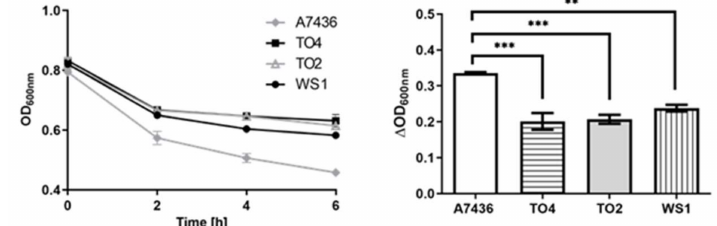
Figure 9. Interaction of S. gordonii with P. gingivalis strains. The tendency of S. gordonii to co-aggregate with P. gingivalis wild type (A7436) and mutant strains lacking hmuY (TO4), hmuR (WS1) and both hmuY and hmuR genes was monitored by measuring optical density at 600 nm at the indicated time points (left panel) or after 6 h (right panel). A7436, wild type P. gingivalis strain; TO4, ∆ hmuY mutant strain; TO2, ∆ hmuY ∆ hmuR mutant strain; WS1, ∆ hmuR mutant strain. All mutant strains were constructed in the A7436 wild type strain. ** p < 0.01; *** p <